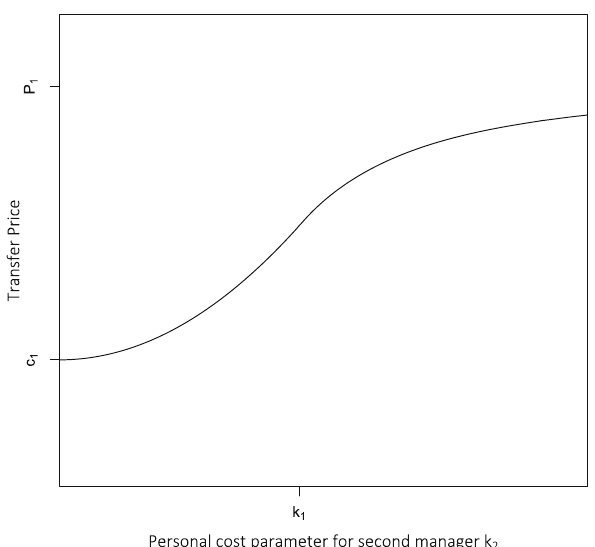
Fig. 1 The optimal transfer price as a function of the difficulty of the incentive problem in division